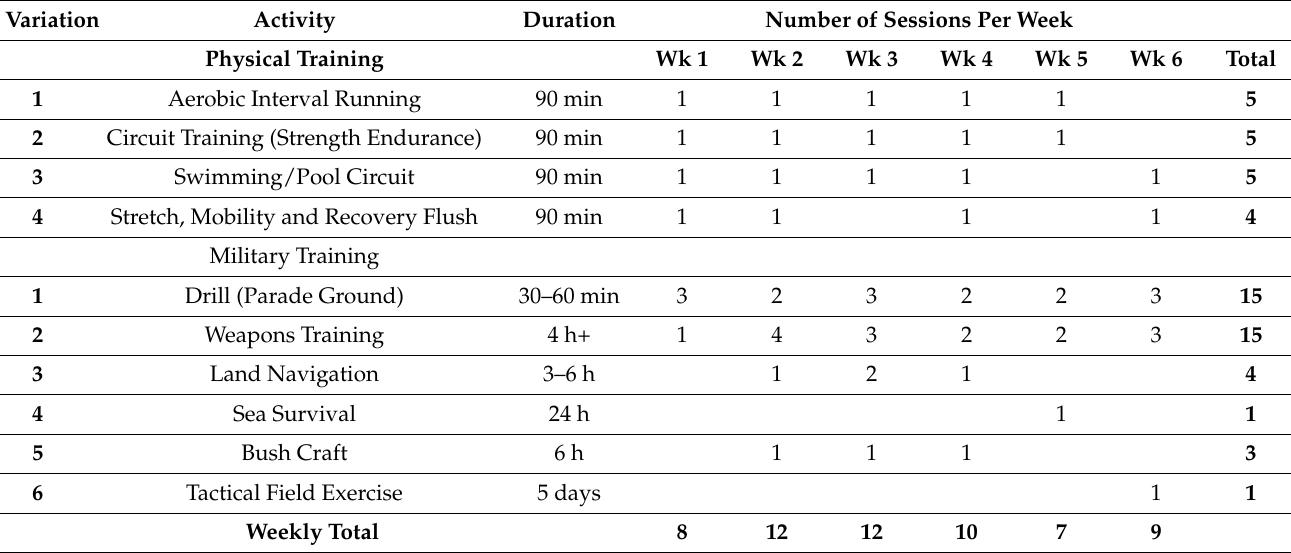
Table 1. Joint officer induction course physical and military training program